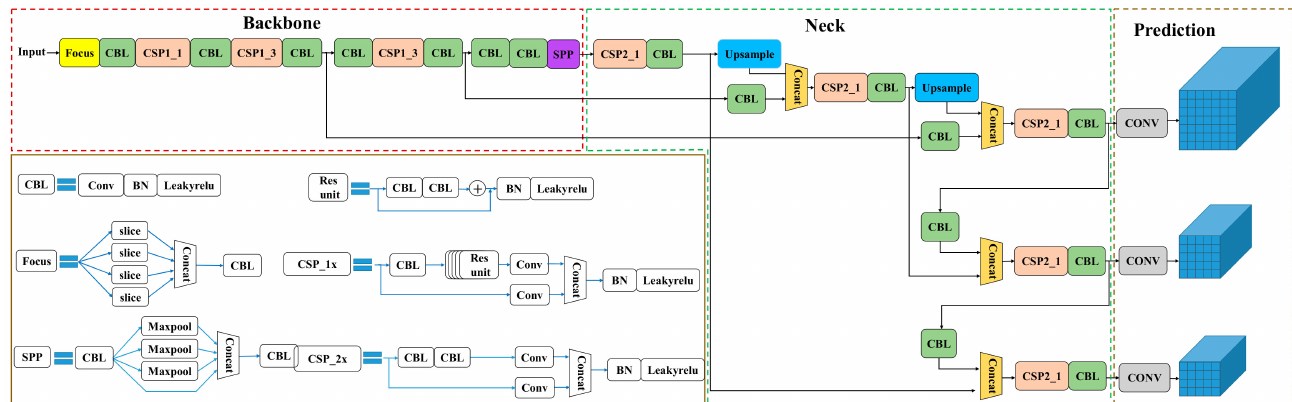
Figure 3. The YOLOv5-based detection network of Chinese